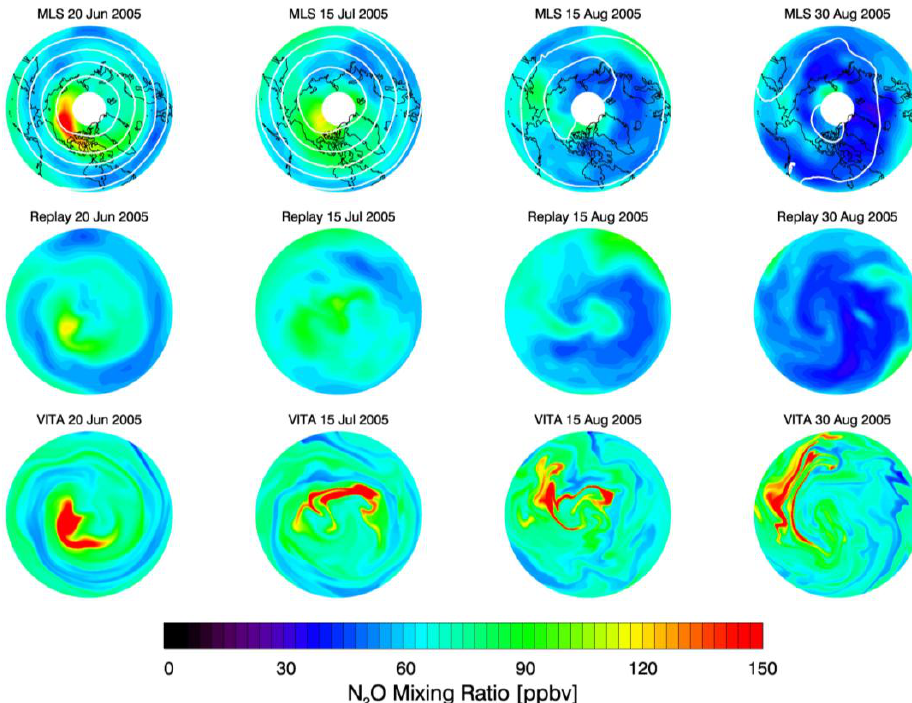
Fig. 14. MLS N 2 O mixing ratio at 850K from 50–90 ◦ N for 20 June, 15 July, and 15 and 30 August 2005 overlaid with contours of 10hPa Figure 14. MLS N geopotential height at 100-m intervals (first row). Red (blue) indicates high (low) N 2 O values. Replay N 2 O simulations for the same days (second row). VITA N 2 O simulations initialized on 1 June 2005 (third August 2005 overlaid with contours of 10 hPa geopotential height at 100-m intervals (first 3 row). Red (blue) indicates high (low) N (second row). VITA N